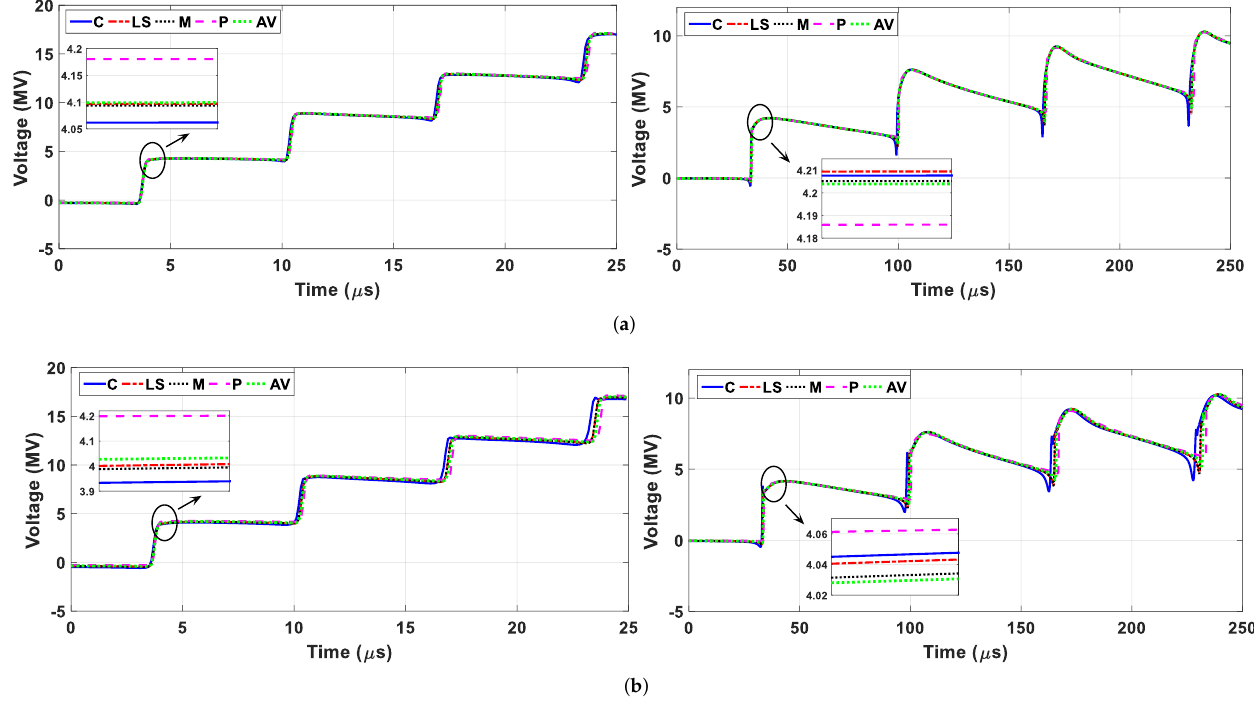
Figure 18. Transient voltages at the receiving end of phase 1 V B obtained for the lightning direct 1 strike for the 1 km OHTL ( left ) and 10 km OHTL ( right ) with ρ 0 of: ( a ) 700 Ω · m and ( b ) 4000 Ω .m. According to the Figure 18, the transient voltages generated for the lightning strike present multiple peaks due to the reflections between the sending and open receiving ends. Furthermore, the voltage peaks are lower for the longer line length due to